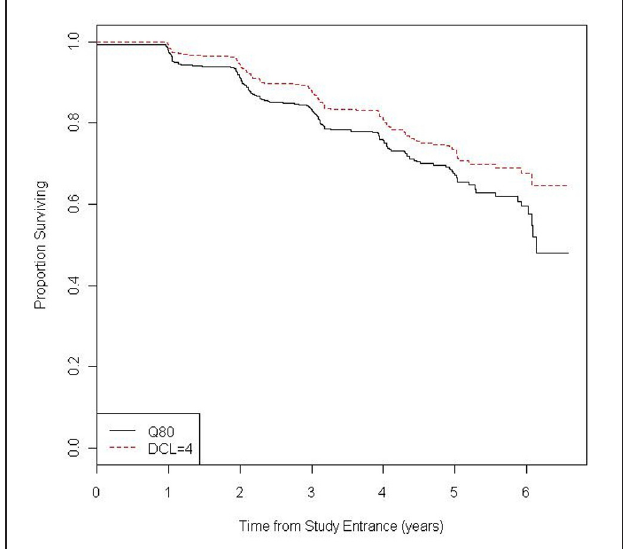
FIGURE 1 | Kaplan-Meier estimate of the probability of being diagnosis-free during follow-up by type of diagnosis (UHDRS Q80 = yes and UHDRS DCL = 4).